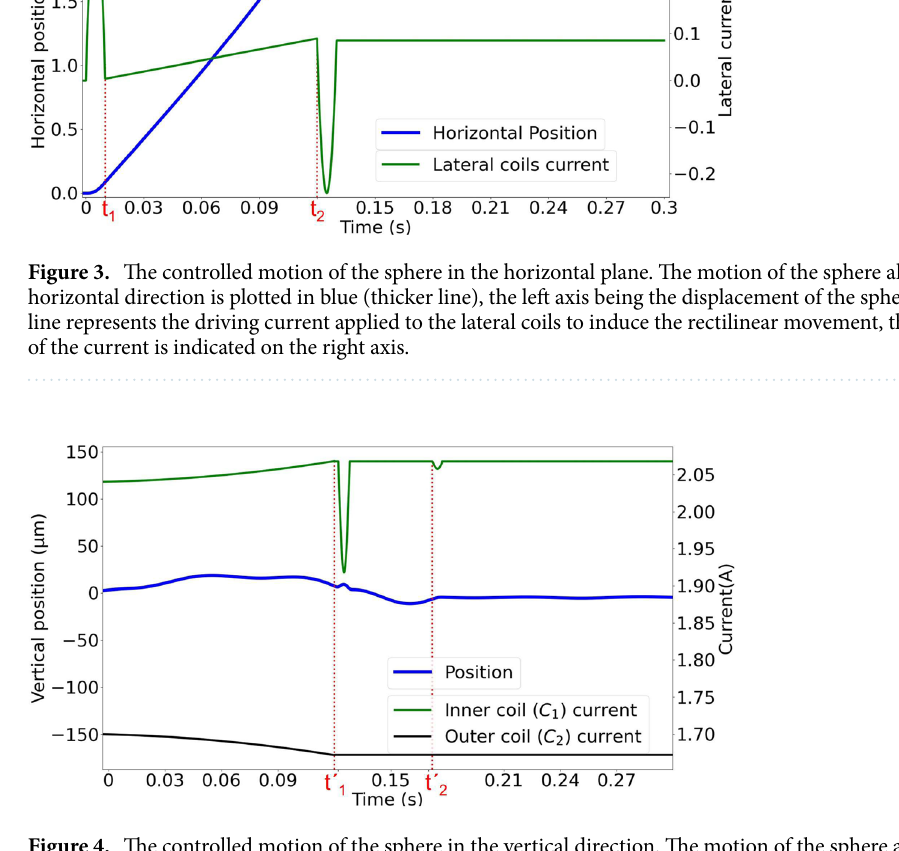
Figure 4. The controlled motion of the sphere in the vertical direction. The motion of the sphere along the vertical direction is plotted in blue (thicker line). The green line (upper line) represents the current applied to the inner bottom coil ( C 1 ), while the black line is the absolute value of the current applied to the outer bottom coil ( C 2 ). Note that the currents in the coils have opposite directions. Counterphase pulses to decrease the magnitude of the oscillations are applied to the inner